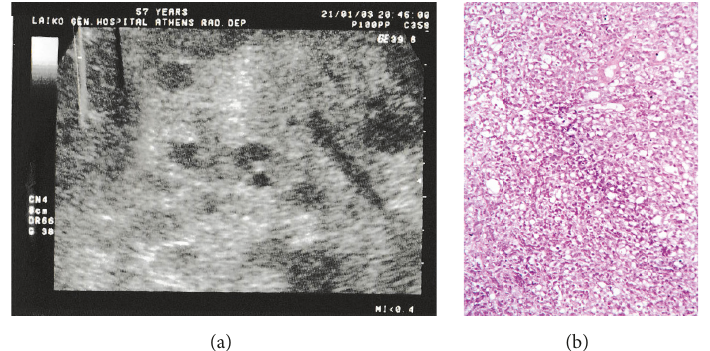
Figure 1: (a) Ultrasonography image showing multiple hypodense lesions suggestive of infiltration of the lymphoma. (b) Diffusely infiltrating medium-sized cells with basophilic cytoplasm, coarse chromatin, and medium-sized nucleoli are seen (H&E stain, ×